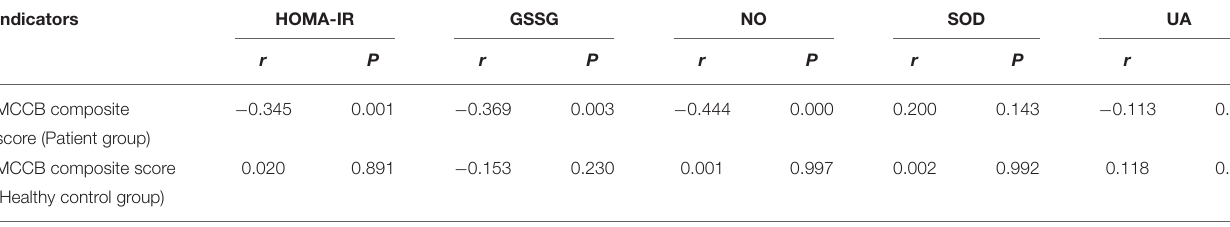
TABLE 4 | Correlation of FINS, HOMA-IR, GSSG, NO, SOD, and UA values with PANSS in patient group ( N = 90). Indicators